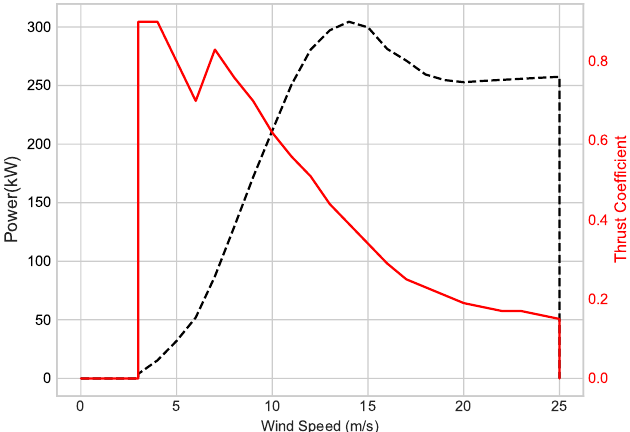
Figure 3. Turbine Power and Thrust Curve: Power (kW) and thrust coefficient ( C t ) versus wind speed (m/s) of the Bonus 300 kW MkIII wind turbine generator with U in = 3 m/s, U r = 14 m/s, U out = 25 m/s, D = 31 m, and z hub = 30 m, C pmax = 0.5923